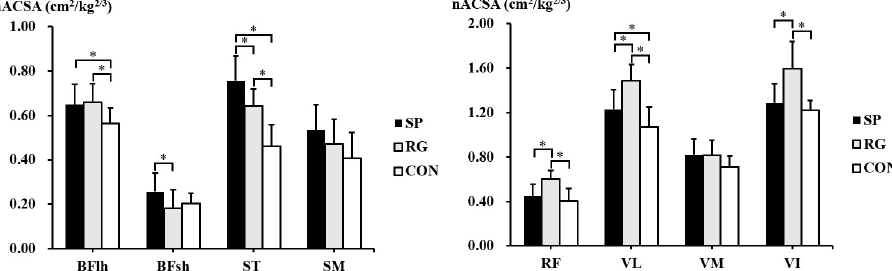
Fig 3. The normalized anatomical cross-sectional area of the individual muscles of the hamstrings and quadriceps femoris in the sprinters (SP), rugby players (RG), and non-athletes (CON). � Significant difference between the groups. BFlh, biceps femoris long head; BFsh, biceps femoris short head; ST, semitendinosus; SM, semimembranosus; RF, rectus femoris; VL, vastus lateralis; VM, vastus medialis; VI, vastus